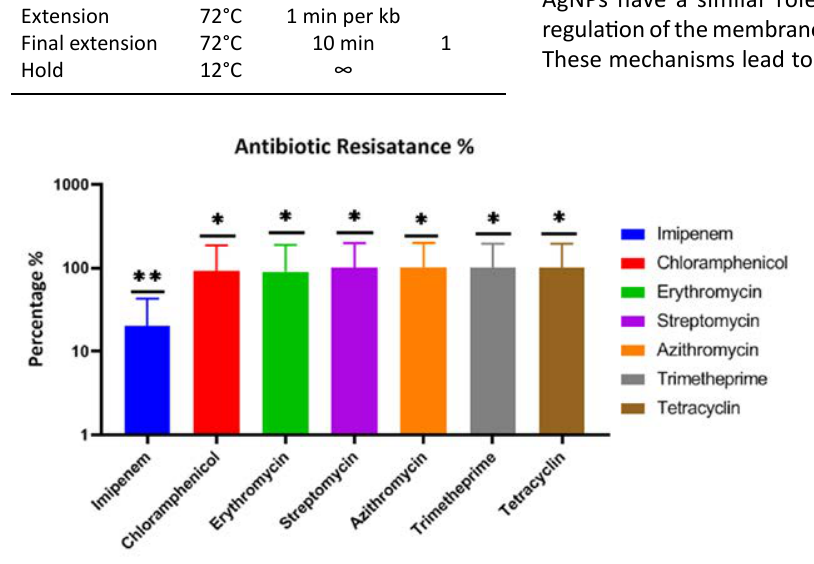
Fig. 2. The percentage of antibiotic resistance of P. aeruginosa strains isolated from cystic fibrosis (CF) in al Muthanna hospitals shows the highest percentage of the resistance for all antibiotics were tested, while the strains were shown the lowest resistance level against imipenem. The p-value of antibiotics resistance is 0.0212 that measured using ANOVA, GraphPad Prism software. **: the population means are significantly different at the p-value= 0.05